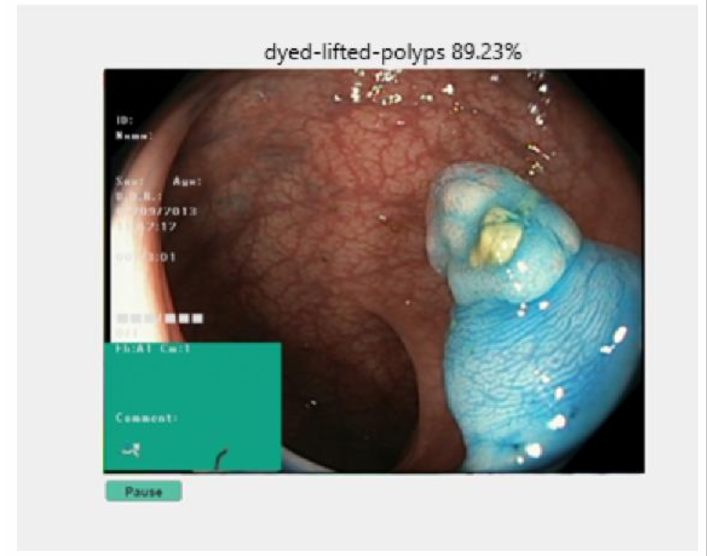
Figure 12. Online colonoscopy.